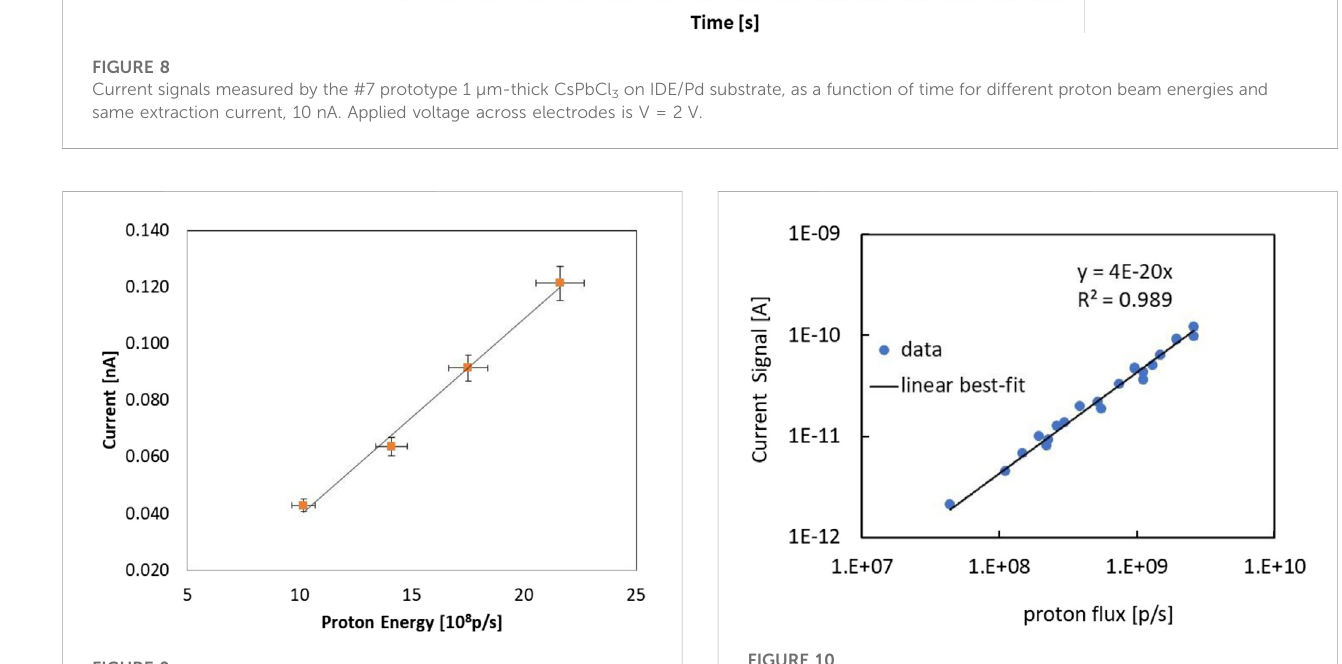
FIGURE 9 Average current measured by the 1 μ m-thick CsPbCl 3 IDE/Pd prototype #7 (applied voltage V = 2 V) as a function of the proton fl uxes corresponding to the beam energies 198-211-220 – 228 MeV and same extraction current (10 nA), polynomial fi t added as a guide-line.